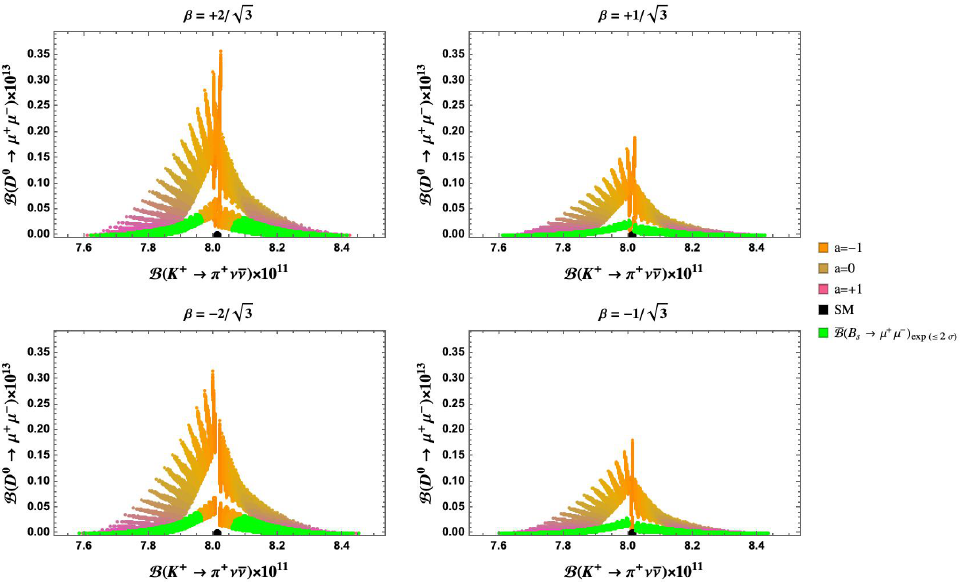
Figure 10 . Correlation between B ( D 0 → µ + µ − ) and B ( K + → π + ν ¯ ν ) in 331 models with parame- ters as in figure 8. The black dot represents the SM result. The green points are obtained requiring that B ( B + µ − ) lies in the experimental range within 2 σ s → µ